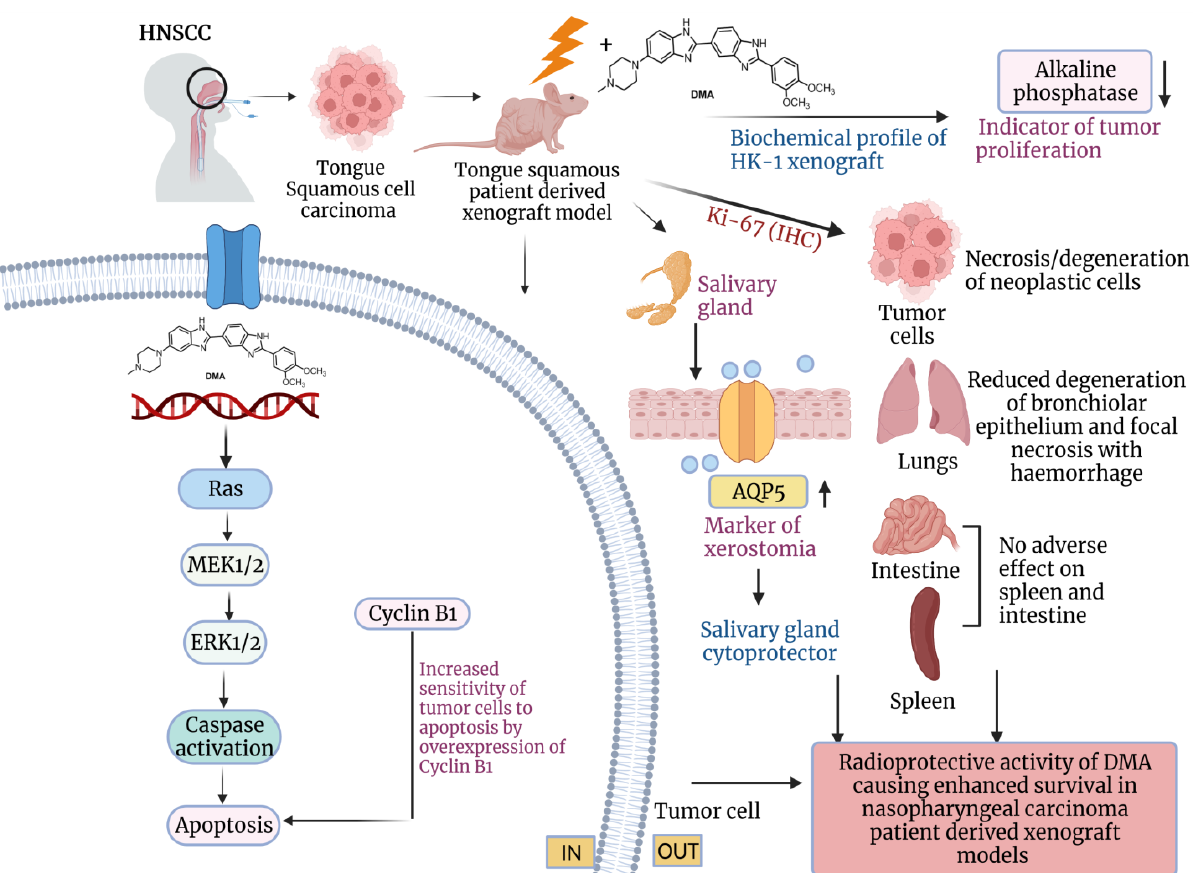
Figure S2: Graphical representation of the tumor formation rate of ( A ) F 0 generation, ( B ) F 1